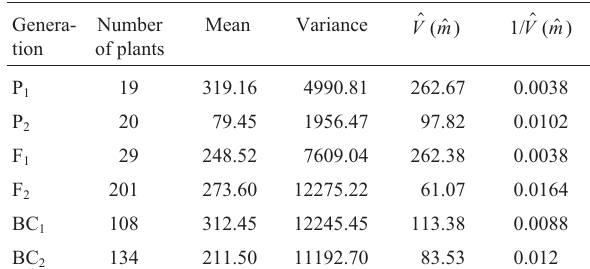
Table 3 - Estimates of the means and variances for the severity of late blight caused by Phytophthora infestans in the parental (P 1 , P 2 ), filial (F 1 , F 2 ) and backcross (BC 1 , BC 2 ) generations of the tomato cross ‘Santa Clara’ x BGH 6902.